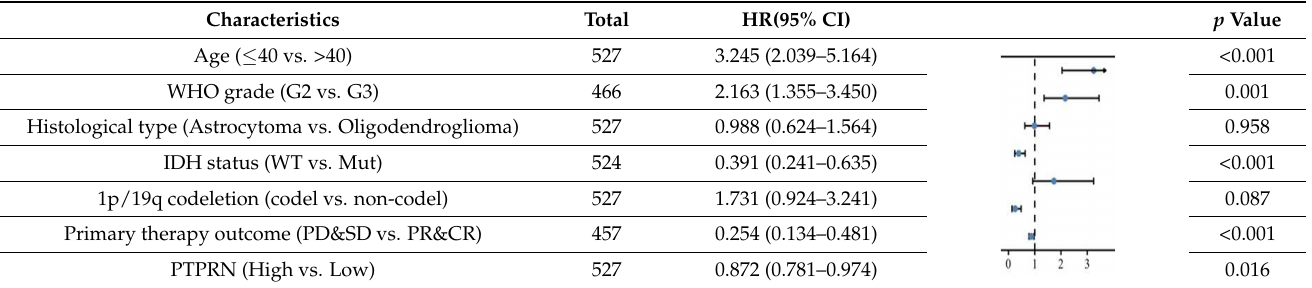
Table 1. Multivariate Cox regression analysis of clinicopathological features (including PTPRN expression) with OS in the TCGA